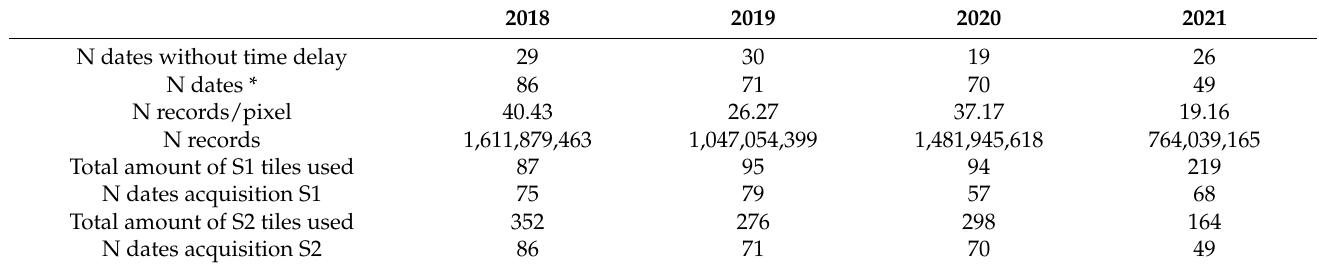
Table 4. Descriptive statistics of the available dataset. (*) the number of available dates = number of dates for S2 data acquisition.